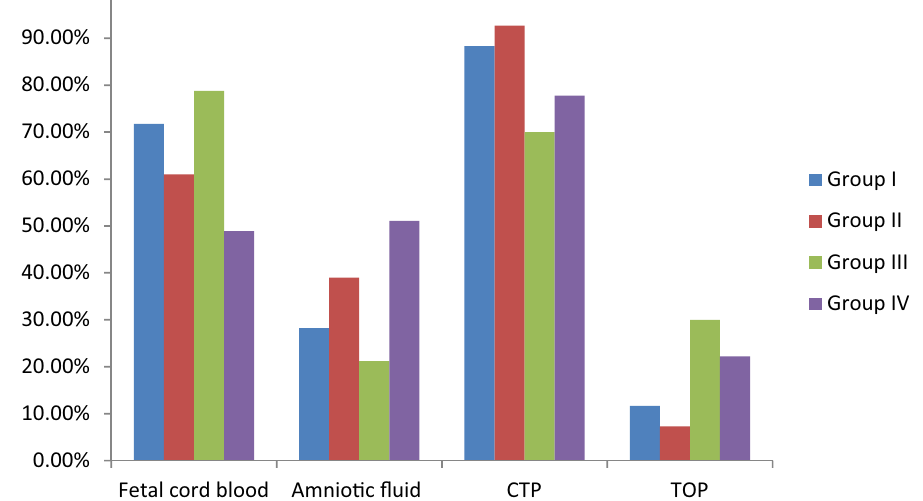
Figure 1. Demographic characters except for gestation age at invasive prenatal diagnosis for 222 pregnant women of ventriculomegaly in fetuses.